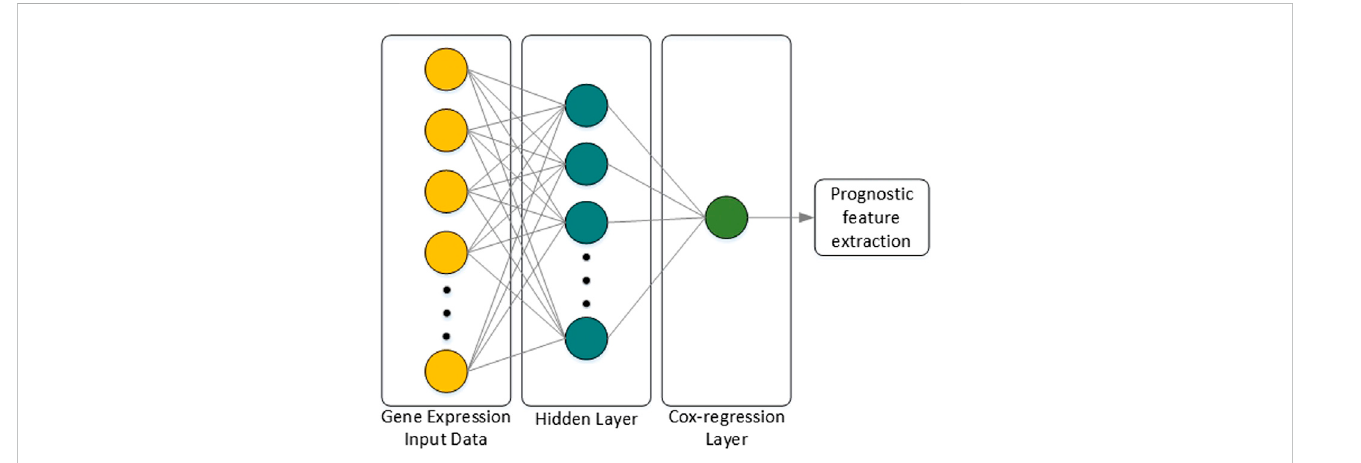
FIGURE 4 Architecture of Cox-nnet. The neural network structure is composed of the input layer, one fully connected hidden layer, and an output Cox regression layer. Finally, among many features of the patient, features related to prognosis are